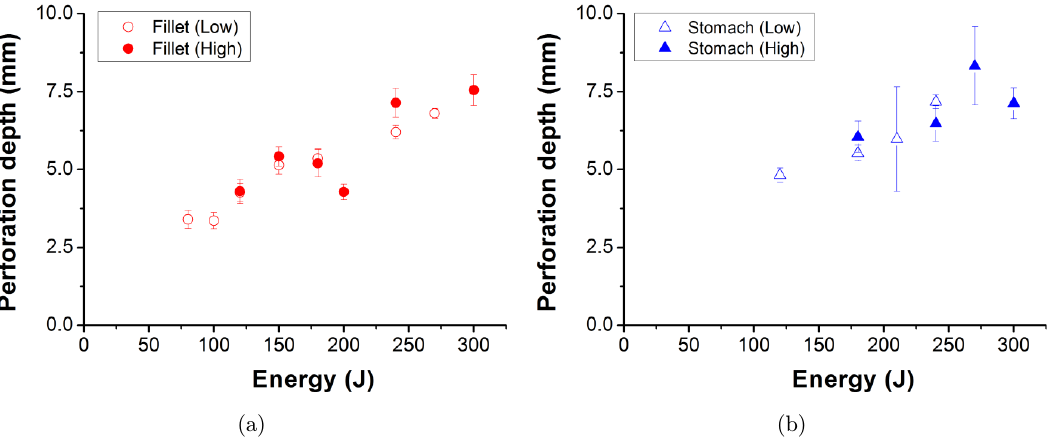
Fig. 4. Perforation depths (a) in the ¯llet and (b) in the stomach tissue samples at low ( < 10 W) and high ( (cid:2) 10 W) laser output powers. Comparison of perforation depth in the ¯llet and stomach tissue samples at (c) low and (d) high output